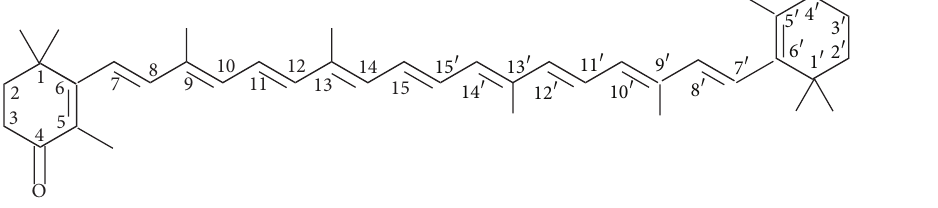
Figure 1: Chemical structure of canthaxanthin.